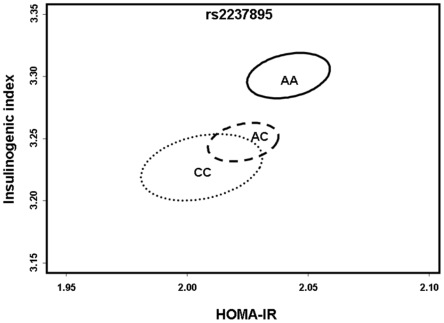
Multivariate analysis on the effect of the minor C-allele of KCNQ1 rs2237895 on insulin release in response to the level of insulin sensitivity in 4,568 glucose tolerant individuals from Inter99.The multivariate method, Hotelling's T2
[36], was applied to test the simultaneous effect of genotype on insulinogenic index and HOMA-IR for rs2237895. Two-dimensional standard error of the means of each genotype level for insulinogenic index and HOMA-IR were calculated for KCNQ1 rs2237895. Significant multivariate association with the minor C-allele of rs2237895 was detected under an additive genetic model (p = 0.004) suggesting that the association with insulin release was not dependent on the level of insulin sensitivity but a true beta cell abnormality.